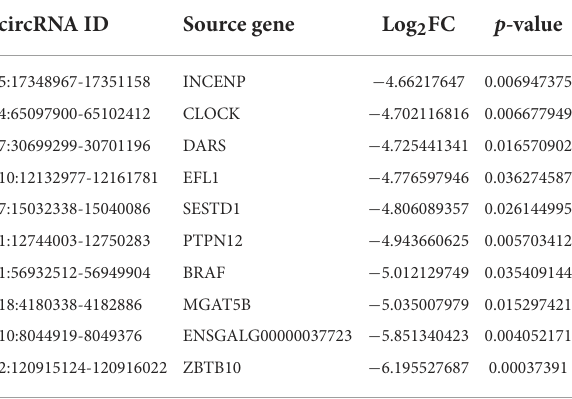
TABLE 2 The top 10 most down-regulated circRNAs in the avian pathogenic E. coli infected HD11 cells compared with the wild type HD11